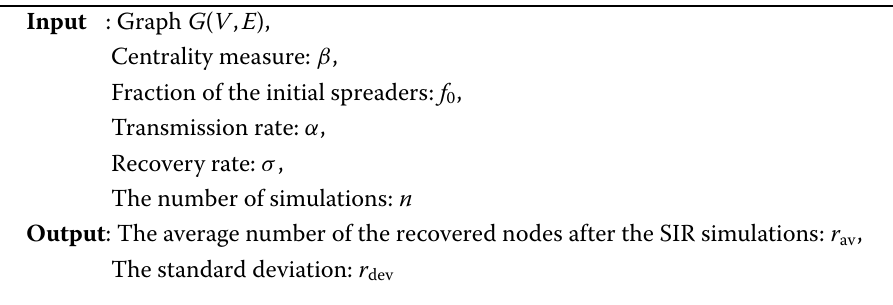
Algorithm 2: Decription of the SIR simulation